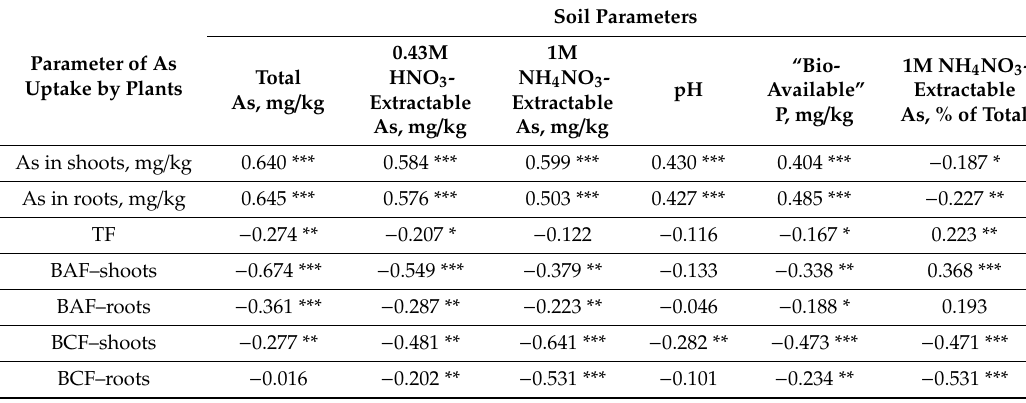
Table 3. Correlations between soil properties and parameters that characterize As uptake by plants ( n = 132). The sets of data lacking a normal distribution were normalized by log-transformation.